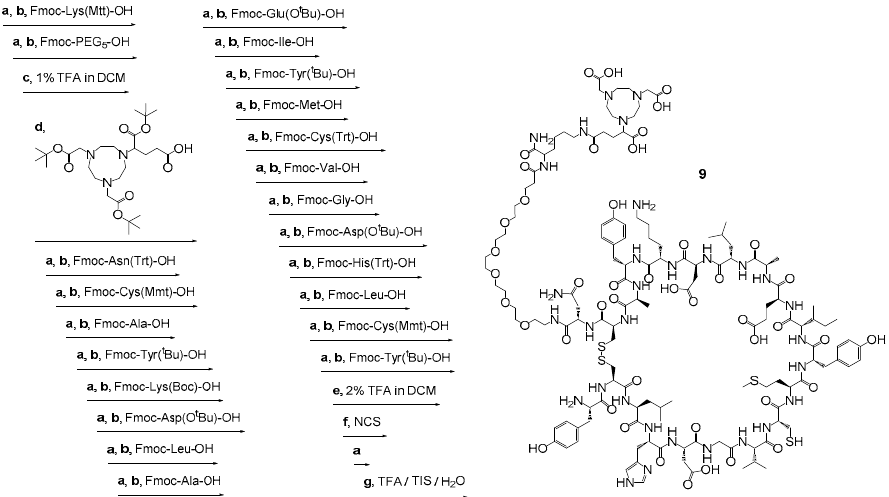
Scheme 1. Schematic depiction of the synthesis strategy of the labeling precursors 1 – 11 exemplified for 9 . Reaction conditions: ( a ) cleavage of Fmoc-protecting group: piperidine/DMF (1/1, v / v ), 2 + 5 min; ( b ) activation of amino acid: 2.0 equiv. amino acid derivative, 2.0 equiv. DIPEA, 1.9 equiv.